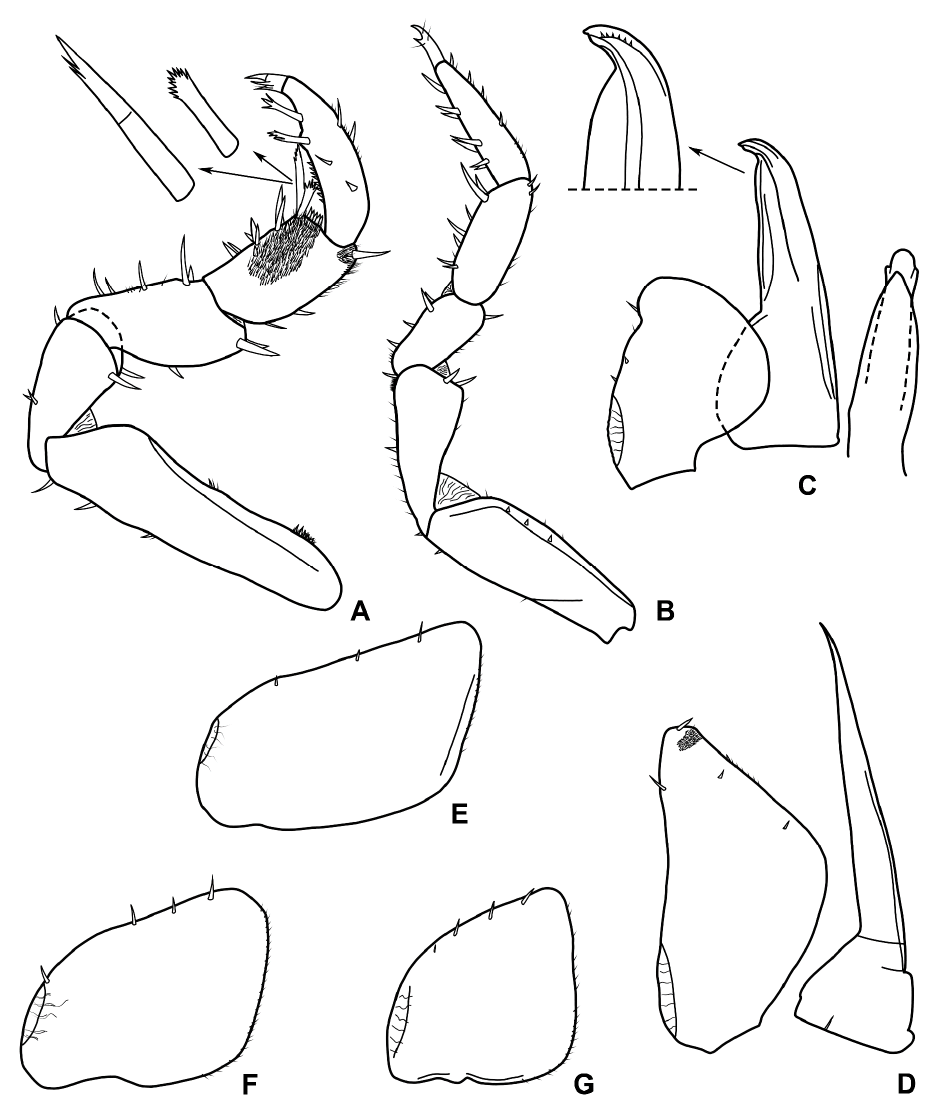
Figure 9. Cylisticus poggii sp. n., paratype ♂ from Isola del Tino. ( A ) Pereopod 1. ( B ) Pereopod 7. ( C ) Pleopod 1 and genital papilla. ( D ) Pleopod 2. ( E ) Pleopod 3 exopod. ( F ) Pleopod 4 exopod. ( G ) Pleopod 5 exopod.